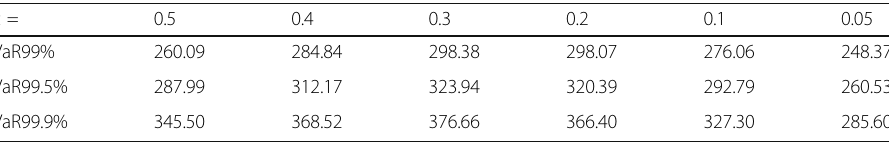
Table 3 Value-at-Risk for a portfolio of two assets (correlation ρ = 0) c = 0.5 0.4 0.3 0.2 0.1 0.05 VaR99% 260.09 284.84 VaR99.5% 287.99 312.17